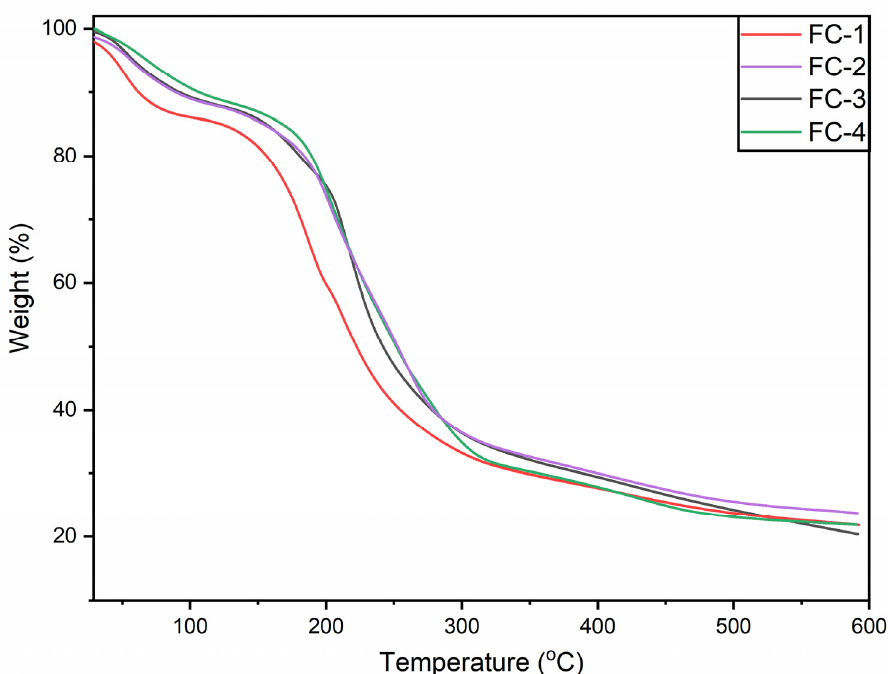
Figure 1. Thermogravimetric analysis of CS–SA edible film samples: control or FC-1, CS + SA; FC-2, CS + SA + FFE (0.5%); FC-3, CS + SA + FFE (1%); and FC-4, CS + SA + FFE (1.5%).